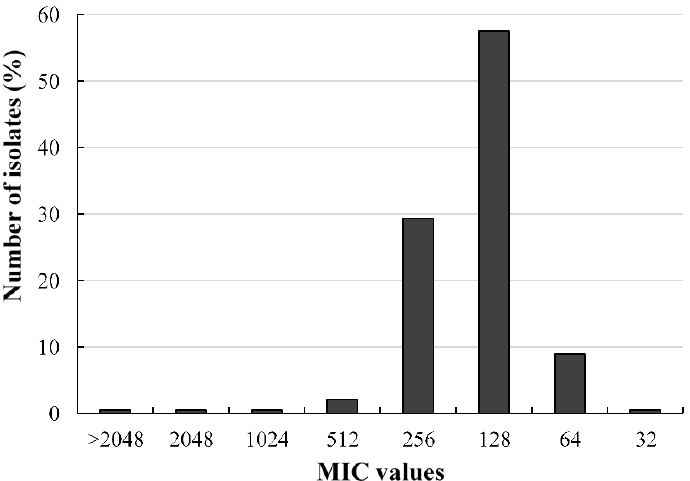
Figure 2. Distribution of the minimum inhibitory concentrations of fosfomycin against clinical A. baumannii isolates, determined by the broth microdilution technique.